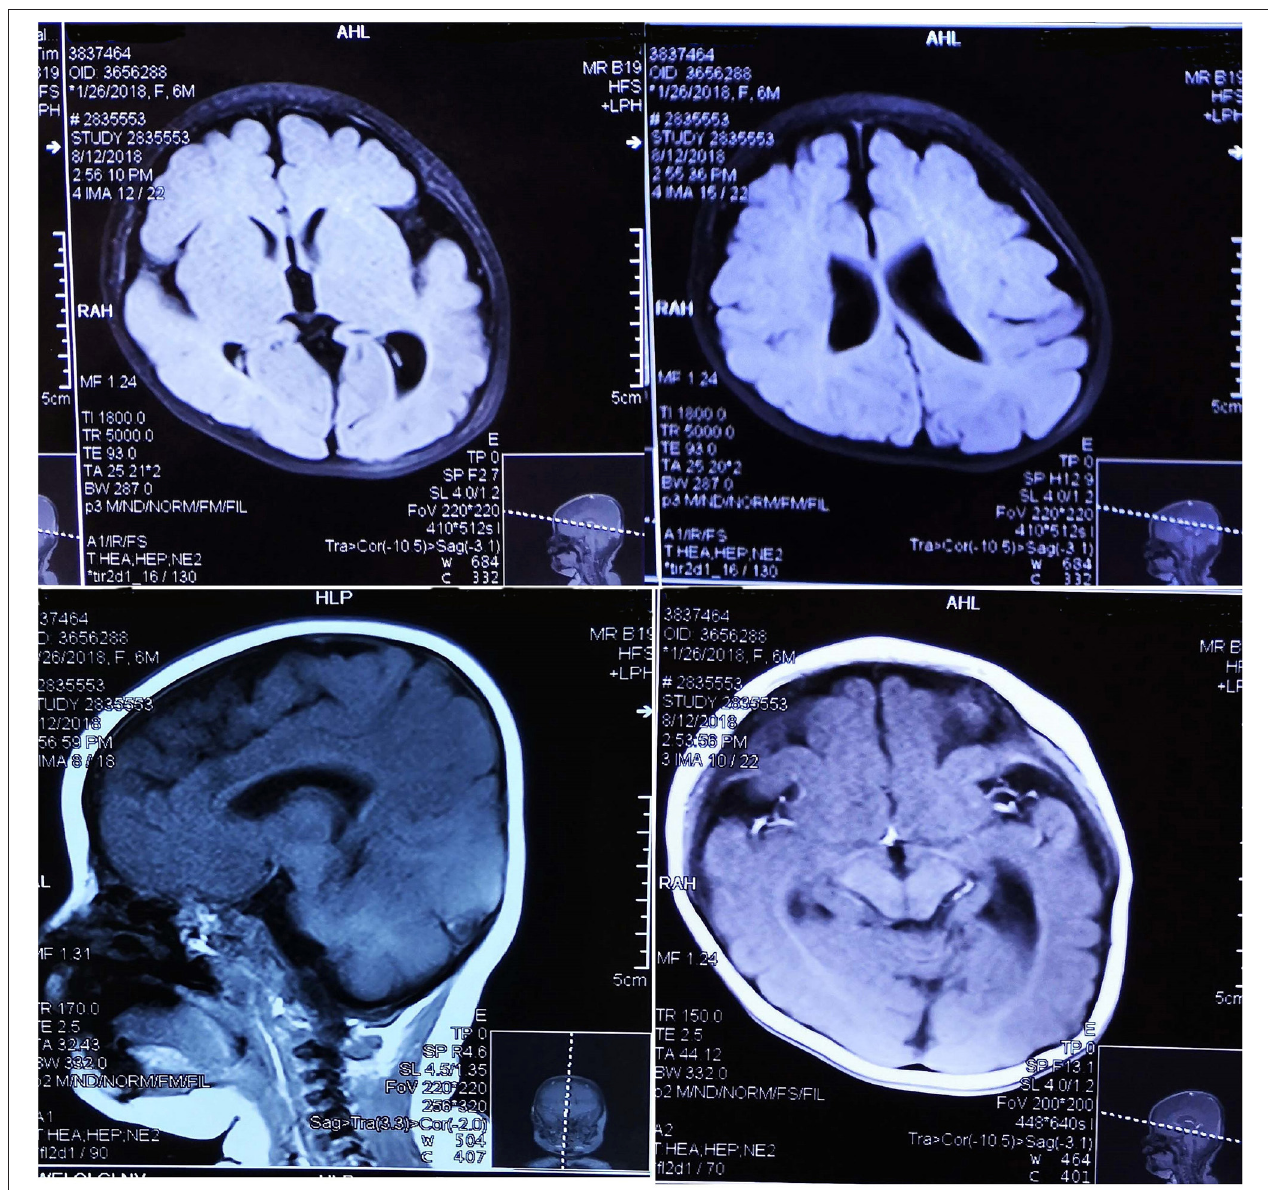
FIGURE 3 | The brain MRI of patient 3 showed